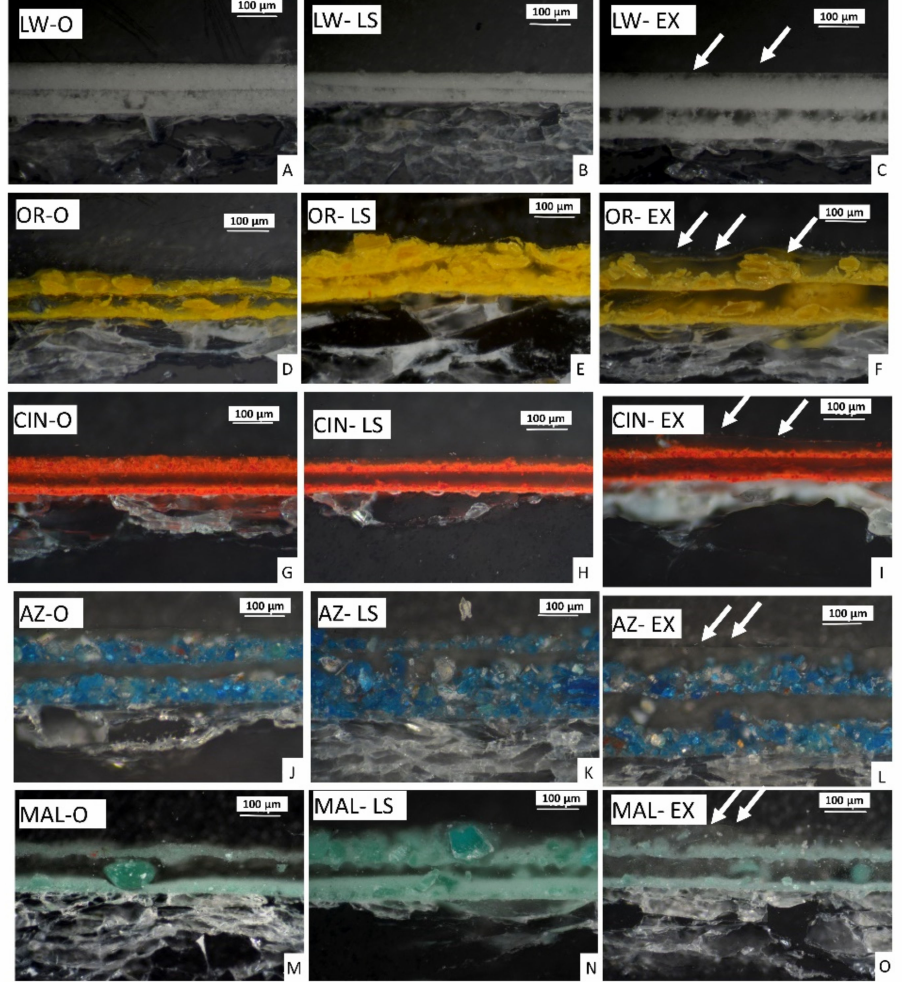
Figure 7. Cross-sections of mock-ups under polarized light microscopy. The samples were examined to determine the influence of the binder quantity (O-optimal quantity-, LS-low binder- and EX-excess binder-) on the reflectance. ( A – C ): lead white (LW)-based oil painting mock-ups. ( D – F ): orpiment (OR)-based oil painting mock-ups. ( G – I ): cinnabar (CIN)-based oil painting mock-ups. ( J – L ): azurite (AZ)-based oil painting mock-ups. ( M – O ): malachite (MAL)-based oil painting mock-ups. Arrows indicate the accumulation of